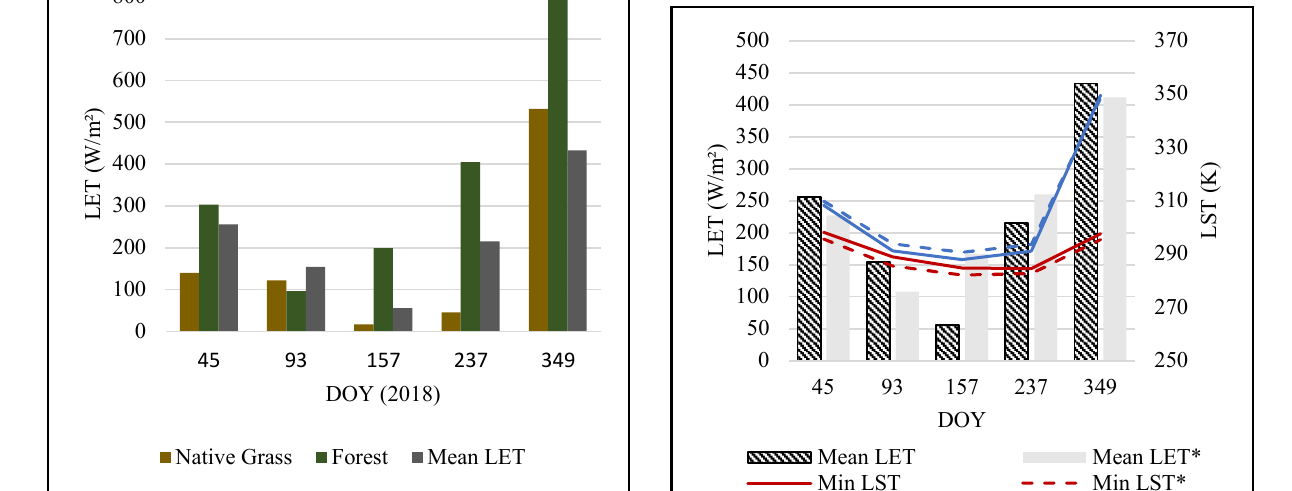
Figure 3. Latent Heat Flux (W/m²) for different land surface use